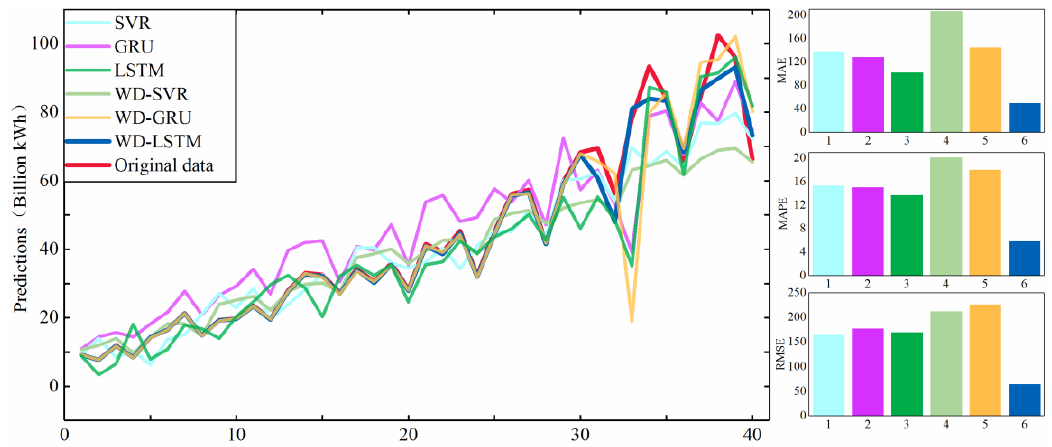
Figure 4. Forecasting performance of the WD-LSTM model and five other models.